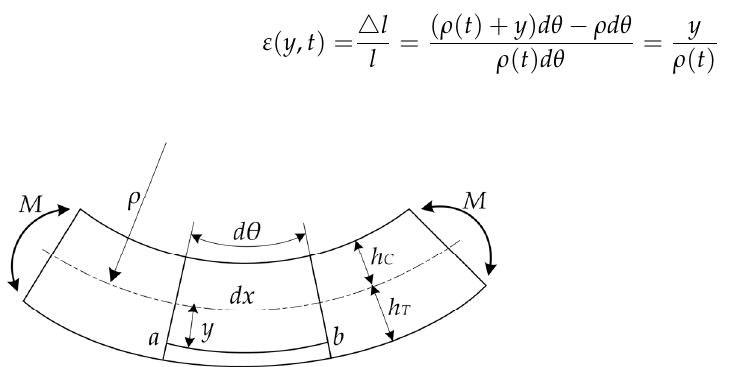
Figure 7. The illustration of displacement under pure bending.